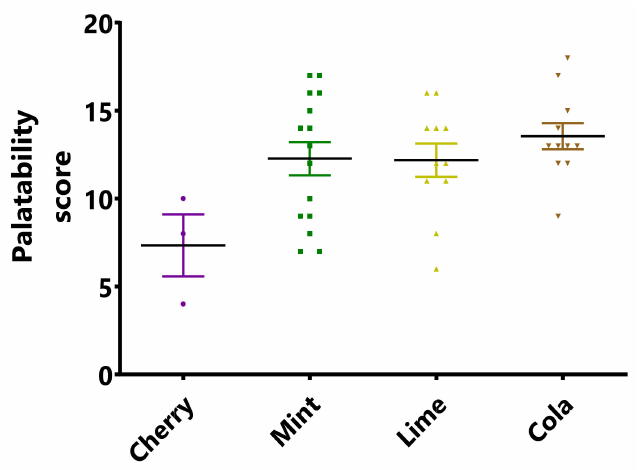
Figure 4. Palatability scores of cherry, mint, lime and cola flavoured TMZ suspensions. Cherry scored was significantly inferior to the other three ( p < 0.05), there was no significant difference between the other 3